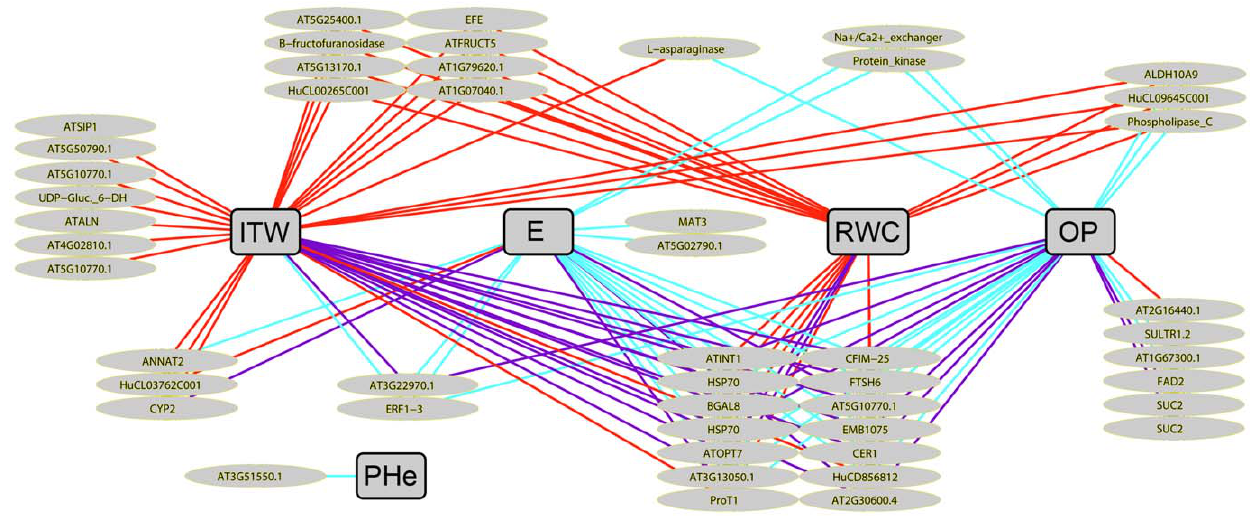
Figure 5. Gene-Phenotype sub-network produced by SPLS, based on responses of eight sunflower genotypes to two drought stress scenarios implemented in controlled environment. Only genes regulated by drought stress in field conditions are shown. Each ellipse represents one gene. Blue, red and purple edges indicate, respectively, whether the gene-phenotype association exists under FDS, FIS or both stress scenarios. Sunflower Heliagene cluster IDs are shown when meaningful names of Arabidopsis homologs are not available. Gray squares represent phenotypic responses; OP: Osmotic Potential, E: Transpiration Rate, RWC: Relative Water Content, ITW: Integrated Transpired Water, PHe: Plant Height.